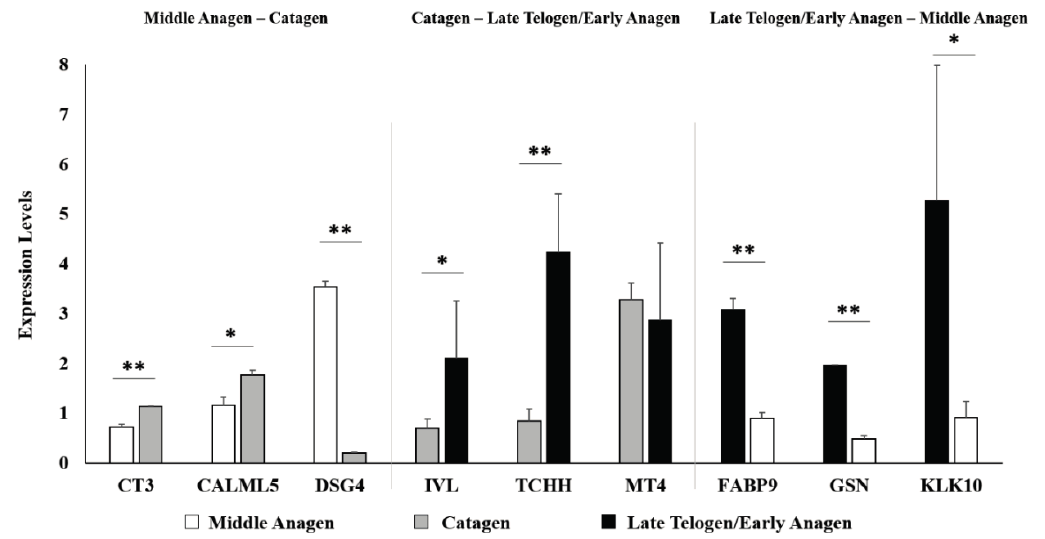
Figure 1. Validation of the sequencing results by qPCR. Nine differentially expressed genes with RPKM (reads per kilobase of exon per million fragments mapped) >5 were selected for validation of the sequencing results by quantitative real-time PCR (qPCR). The results showed good agreement between qPCR and sequencing data (** p < 0.01, * p < 0.05).